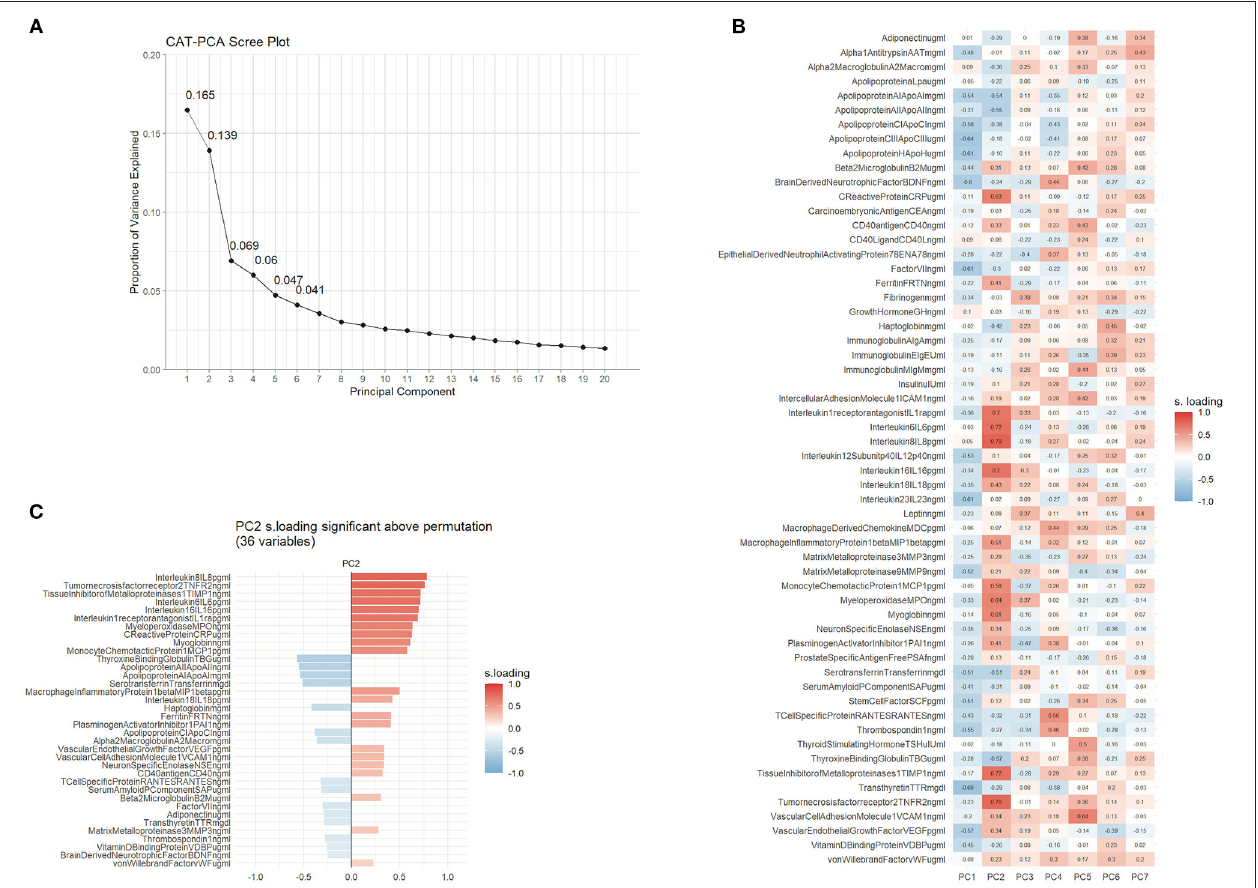
FIGURE 4 | TBI produces multivariate inflammatory profiles. Non-linear PCA of multianalyte assay of 58 proteins. (A) Scree plot showing the proportion of overall variance that was accounted for by each orthogonal PC. The first component (PC1) accounted for 16.5% of the variance, followed by 13.9% of variance accounted for by PC2. There was a precipitous drop in variance accounted in PCs after PC2. (B) Matrix of the first seven PCs by 58 proteins. Heat map shows higher PC loadings in red and lower PC loadings in blue. A biologically interpretable pattern of loadings was identified in PC2, with proteins that loaded strongly being predominantly associated inflammation. (C) Permutation testing in PC2 indicated that the loadings for 36 of the 58 proteins were significantly above